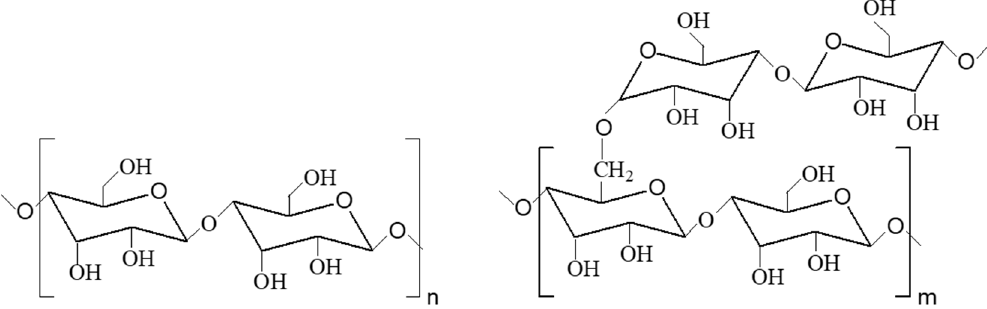
Figure 7. Chemical structure of amylose and amylopectin. In this context, starch was used to provide, or enhance, those particular properties in the WBPU and WBPUU, configuring an attractive eco-friendly alternative. For example, Lee and Kim [98] synthesized a WBPU incorporating vinyltrimethoxysilane (VTMS) mod- ified starch covalently bonded to the polyurethane chains. They observed that the misci- bility of both components and the biodegradability of the material, which was compared with a just blended WBPU-starch system, was improved. With this purpose, after obtain- ing the WBPU dispersion, the VTMS modified starch was incorporated, and the mixture homogenized for the future addition of a photoinitiator. The resultant mixture was cast and cured by UV radiation, resulting in a multifunctional crosslink network structure. The effect of St in the biodegradability process was extensively analyzed using an amylase solution (enzyme capable of catalyzing the breakdown of starch structure into sugars) in a buffer solution. Results showed that when using the amylase medium, the samples’ weight loss was higher than the starch amount presented in the system, implying that the formed network containing St induced the degradation of the polyurethane chains. In the case of WBPU-starch blends, the weight loss was equivalent to the blended St, indicating that it was degraded without promoting the WBPU matrix’s biodegradation. Travinskaya et al. [99] also incorporated St into a WBPU dispersion during the synthesis process (WBPU/starch). The prepolymer dissolved in acetone was dispersed in a water phase con- taining starch, resulting in the combination of the chain extension and dispersion stages. An alternative strategy was also designed by preparing mechanical mixtures (WBPU + starch) for comparison purposes. In this case, the starch in the form of an aqueous solu- tion, was added to the already synthesized WBPU dispersion. It was observed that the WBPU/starch method ensured the chemical and physical interaction between the WBPU matrix and the starch, enhancing the stability to aggregations and the film-forming ability, whereas, in the mechanical mixtures, the intermolecular interactions of each component prevailed. Regarding the film’s biodegradability, the adhesion capacity of microorgan- isms ( Bacillus subtilis ) to the film’s surface was evaluated. Results showed that samples containing starch incorporated during the synthesis process presented higher biodegra- dability than the matrix alone. This fact implied that these samples biodegraded as an entire system, unlike the ones prepared by the mechanical mixture. Furthermore, WBPU/starch samples resulted in systems more susceptible to alkaline and acid hydroly- sis than the base WBPU matrix. Thus, the work showed the possibility of synthesizing degradable WBPU based on renewable starch polysaccharides. Apart from biodegradability, starch-based systems can also enhance other properties such as the mechanical behavior of films, as evidenced by Zou et al. [100] in a representa- tive work where, by acid hydrolysis, starch nanocrystals with a distinct platelet-like